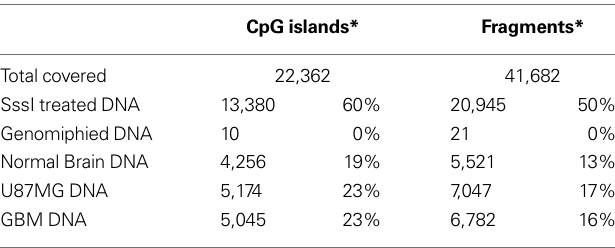
Table 3 | Methylated fragments and corresponding CpG islands detected by MSRE analysis of human genomic DNA samples.